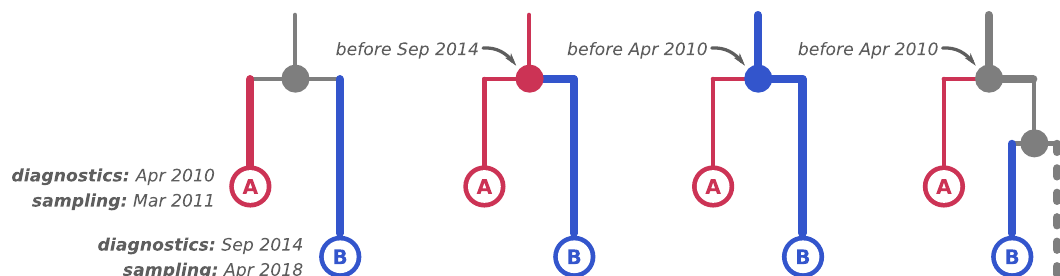
Fig 5. Possible transmission scenarios for two samples. An example internal node that has two tip children, A and B , and their sampling and diagnostics dates are shown on the left. As the internal node corresponds to a transmission, three scenarios are possible: (middle left) A is the donor, therefore the transmission must have happened before the recipient ( B ) got diagnosed; (middle right) B is the donor, therefore the transmission must have happened before the recipient ( A ) got diagnosed; (right) the donor was another individual that was not sampled and does not appear in the tree, therefore that transmission must have happened before both A and B got diagnosed. In practice, however, we cannot know which of the three scenarios is the correct one and therefore have to pick the more recent diagnostics date ( B , Sep 2014) as the upper-bound constraint for the internal